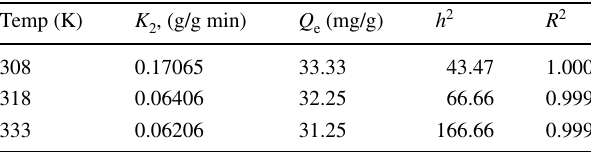
Table 5 Pseudo second order kinetic parameters for the adsorption of MG onto the Neem leaf adsorbent Temp (K)